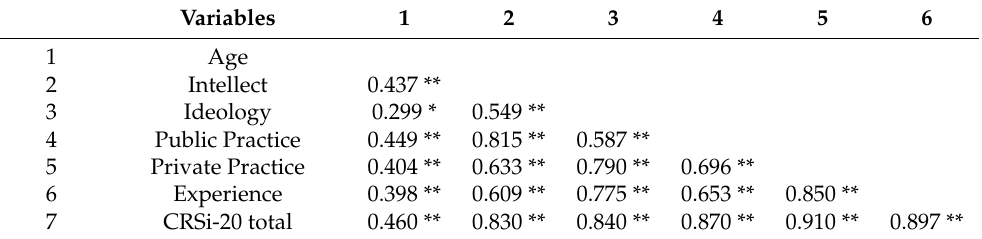
Table 3. Correlation matrix of the respondents’ age, CRSi-20 total score, and its subscales.